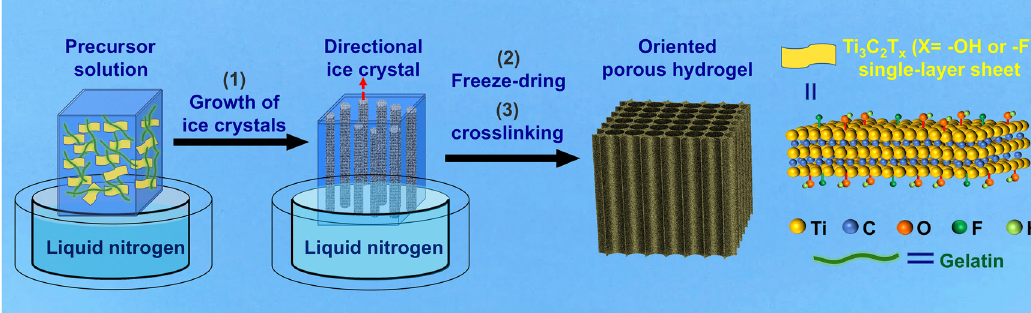
Figure 1: The three - step fabrication of the wood - mimetic oriented macroporous